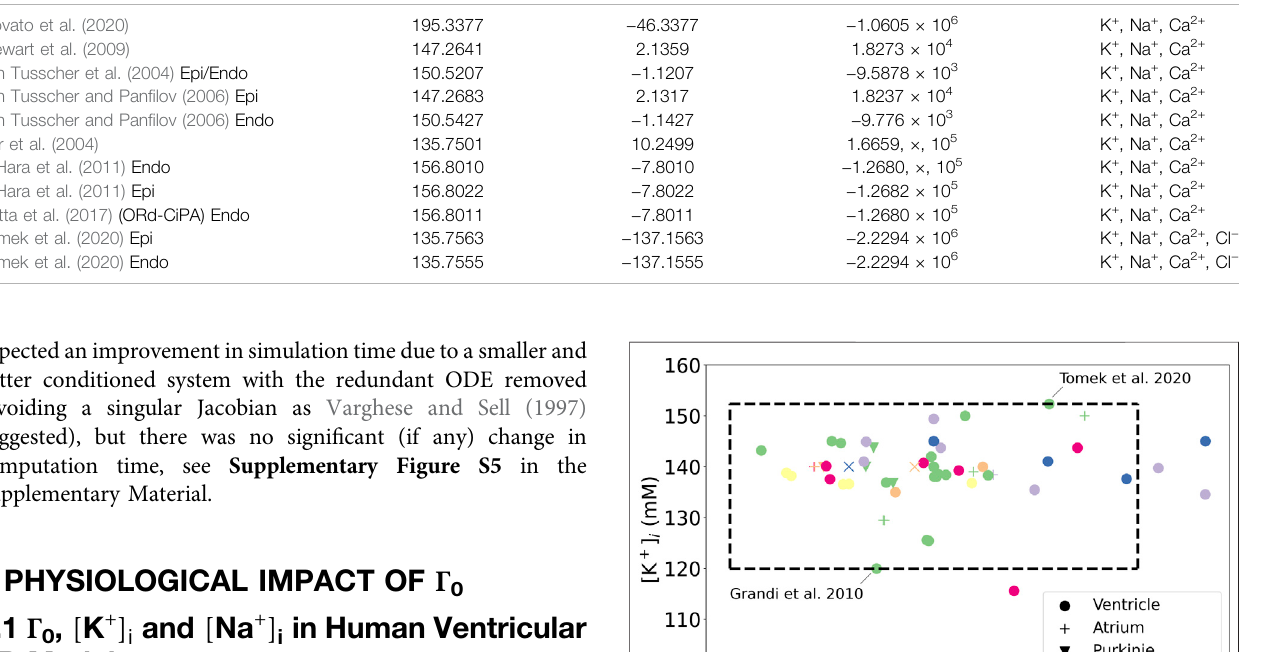
TABLE1| TheintegrationconstantforarangeofhumanAPmodels,writtenas C 0 (Hundetal.,2001) — see Section1.2 — ,netun-modelledspeciesconcentration Γ 0 Eq.6 , and voltage offset Δ V Eq. 5 . The Trovato et al. (2020) and Stewart et al. (2009) models are Purkinje fi bre models, while the remaining models represent ventricular cells. Model